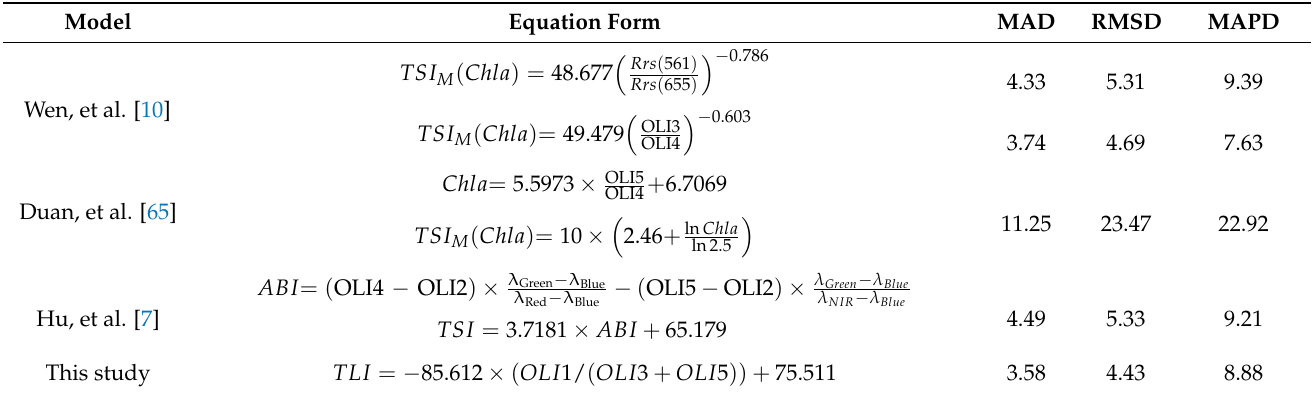
Table 2. Comparison of performance between the existing and proposed TLI-evaluated models based on in situ measurement